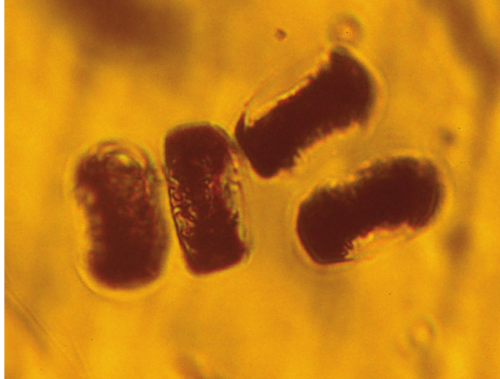
Figure 14: Detail of eggs of Myrmeconema antiqua in various stages of development in Dominican amber.